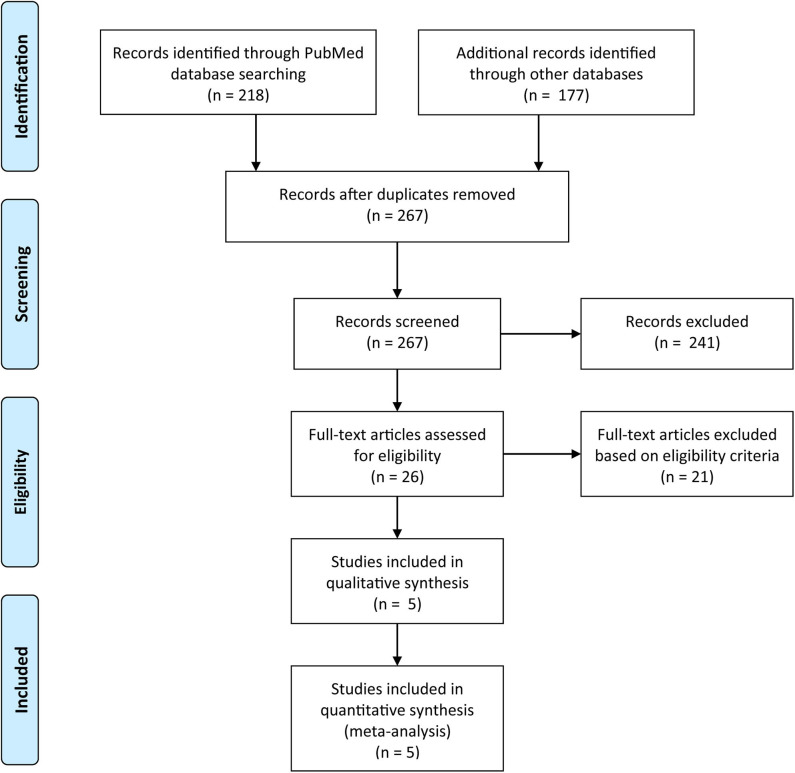
PRISMA flow chart.